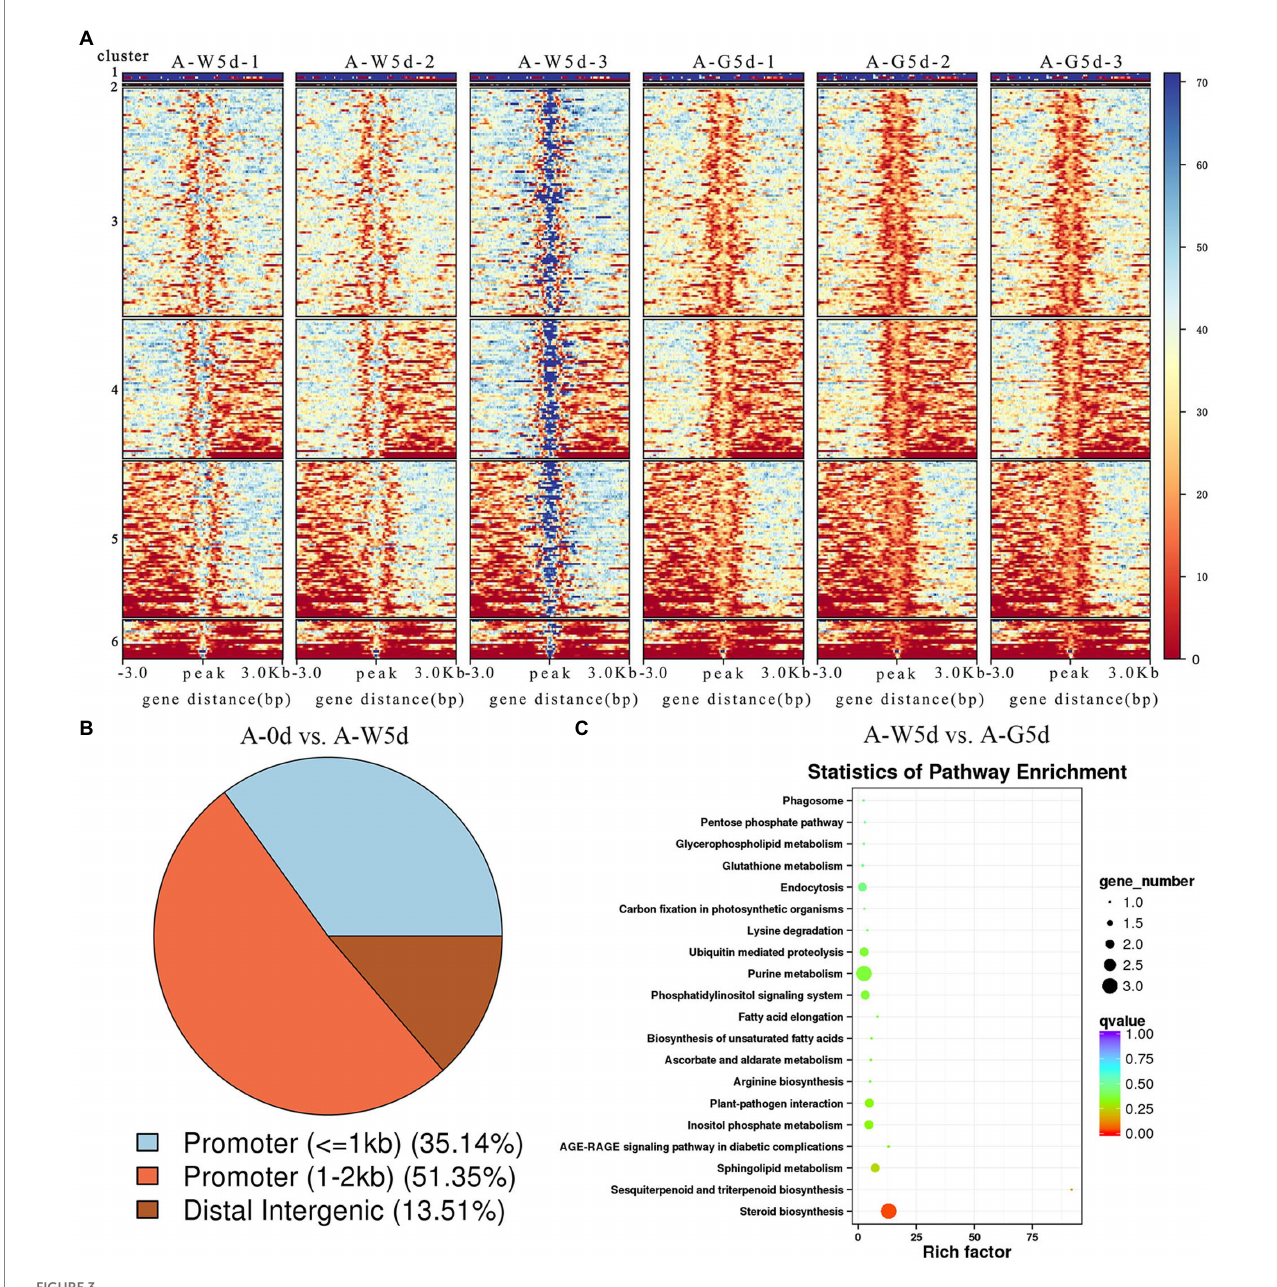
FIGURE 3 Identification and enrichment analysis of DARs-associated gene and motif. (A) Clustering heat map of differential peaks in A-0d, A-W5d, and A-G5d, respectively. (B) Annotation classification map of differential peaks in A-0d vs. A-W5d. (C) KEGG enrichment of DARs-associated genes in A-W5d vs.